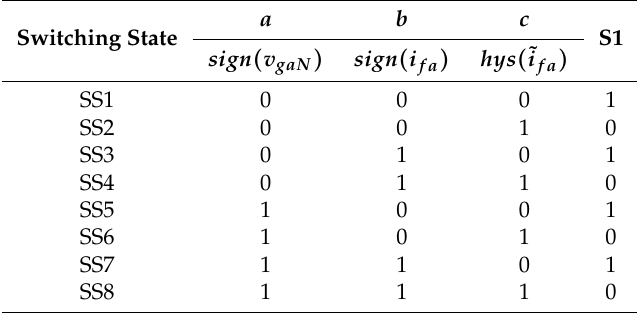
Table 2. Truth table for the switching states of S 1 ( S 1 = S